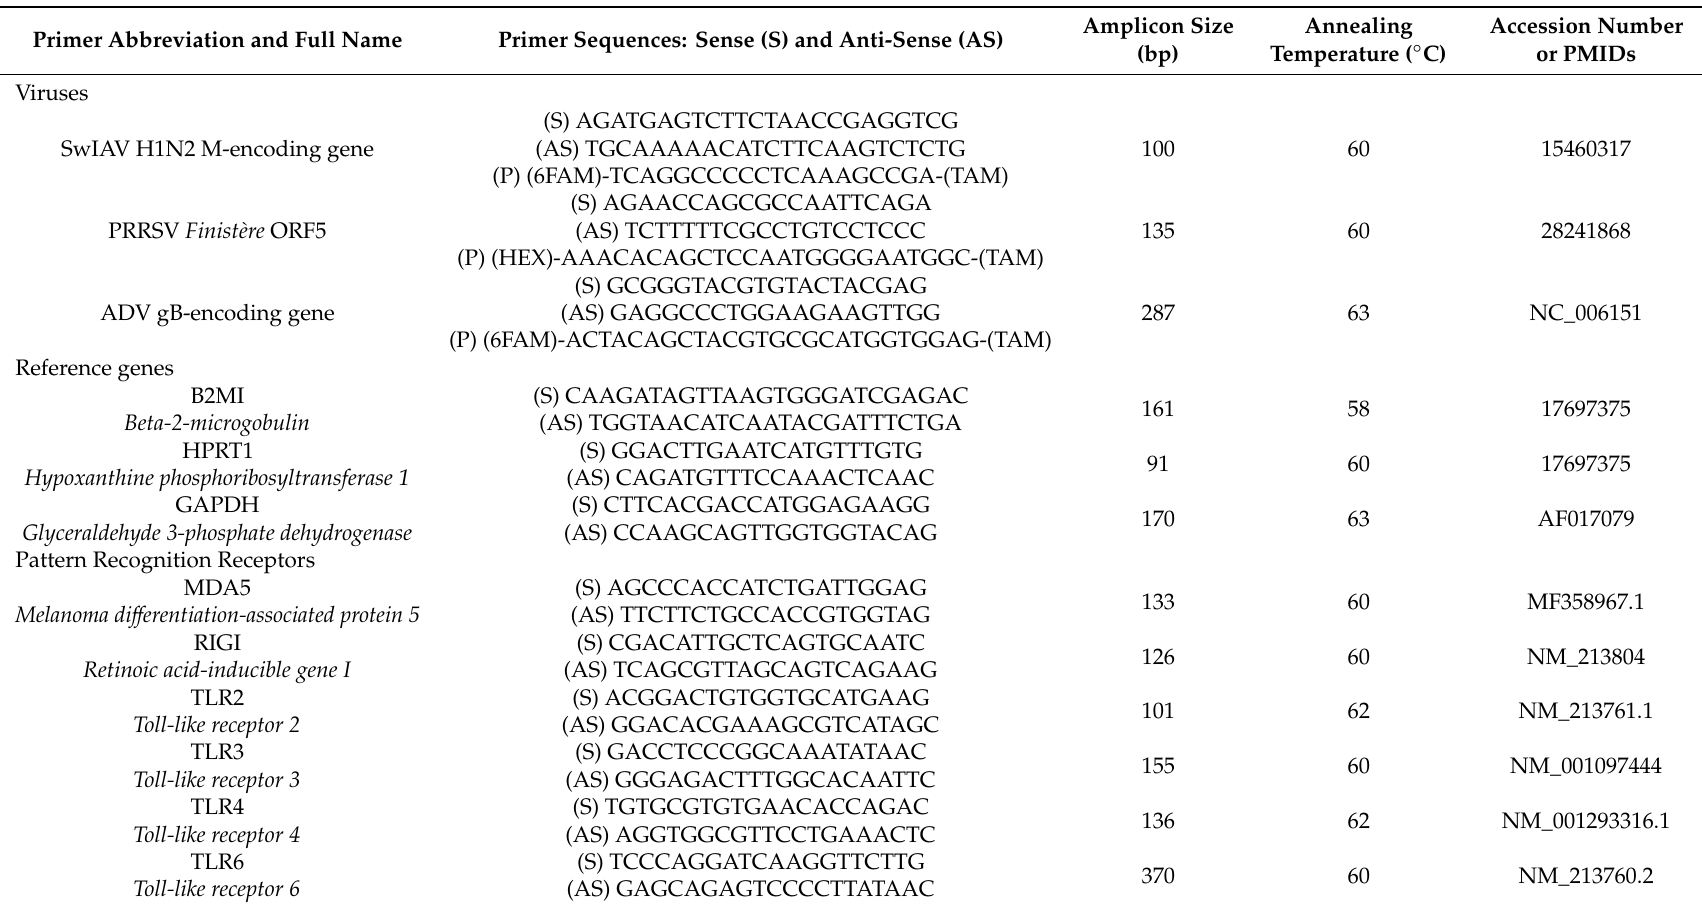
Table 1. List of the primers used in the